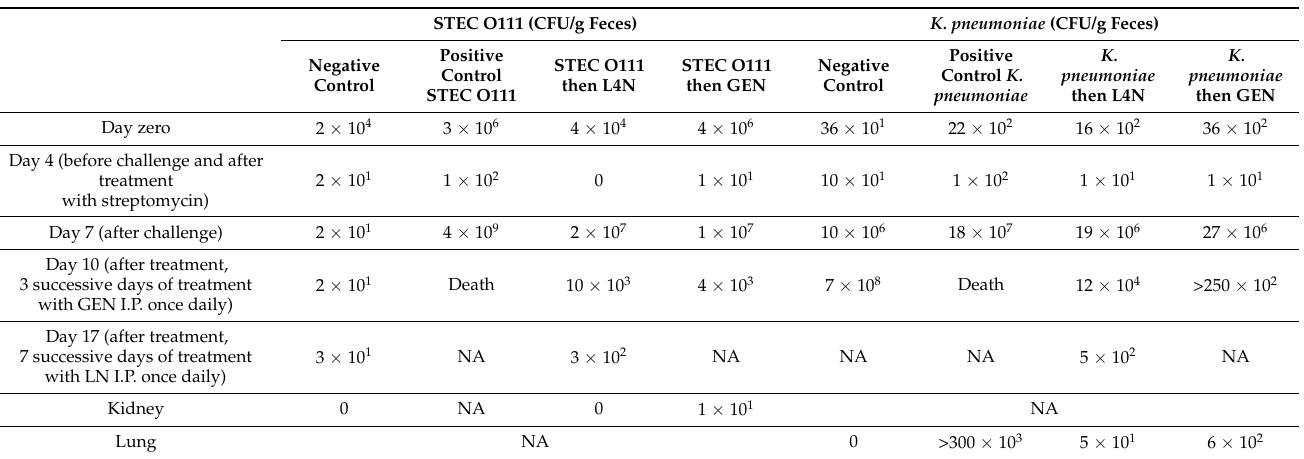
Figure 8. Quantification of K. pneumoniae on MacConkey agar media. Table 7. Quantification of bacterial loads of STEC O111 and K. pneumoniae shed in the feces and bacterial colonization in the kidneys and lungs.